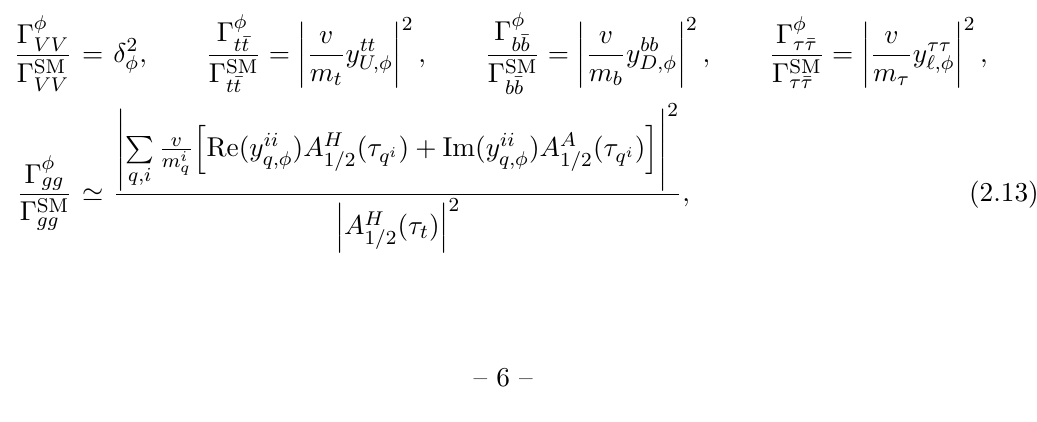
= 0 : 1 while on the bottom row U